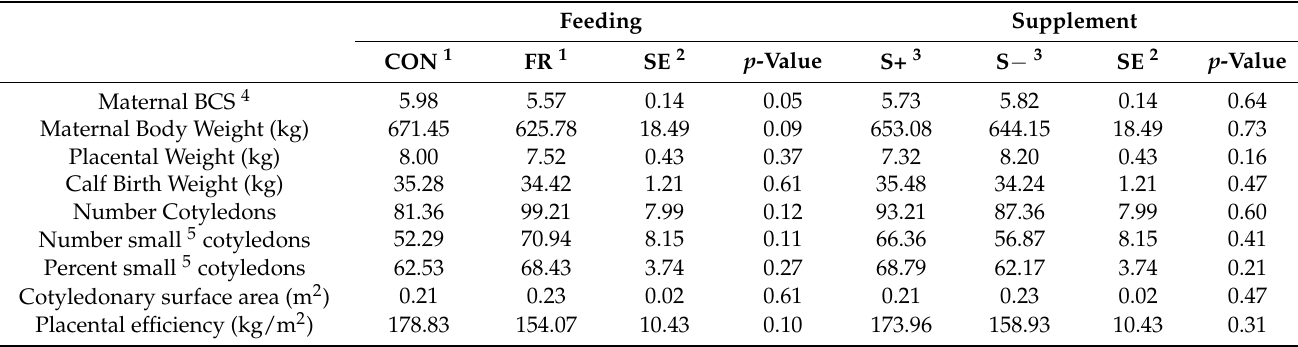
Table 1. Analysis of body weight, BCS, and placental efficiency characteristics in all treatments from the general linear model (GLM) for main effects of feeding treatment and mineral